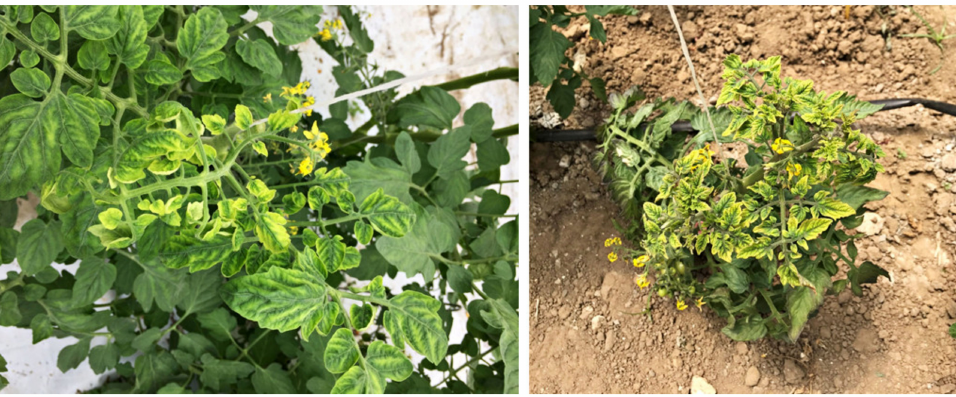
Figure 12. Yellowing and dwarfism symptoms caused by Tomato yellow leaf curl disease. In colder periods, the yellowish colour can acquire purple shades resembling cold damage, as infected plants become more susceptible at low temperatures [2]. TYLCD symptoms may also include the abscission of flowers, failure to fruit set, and the production of unmarketable fruits due to their small size and/or pale colour